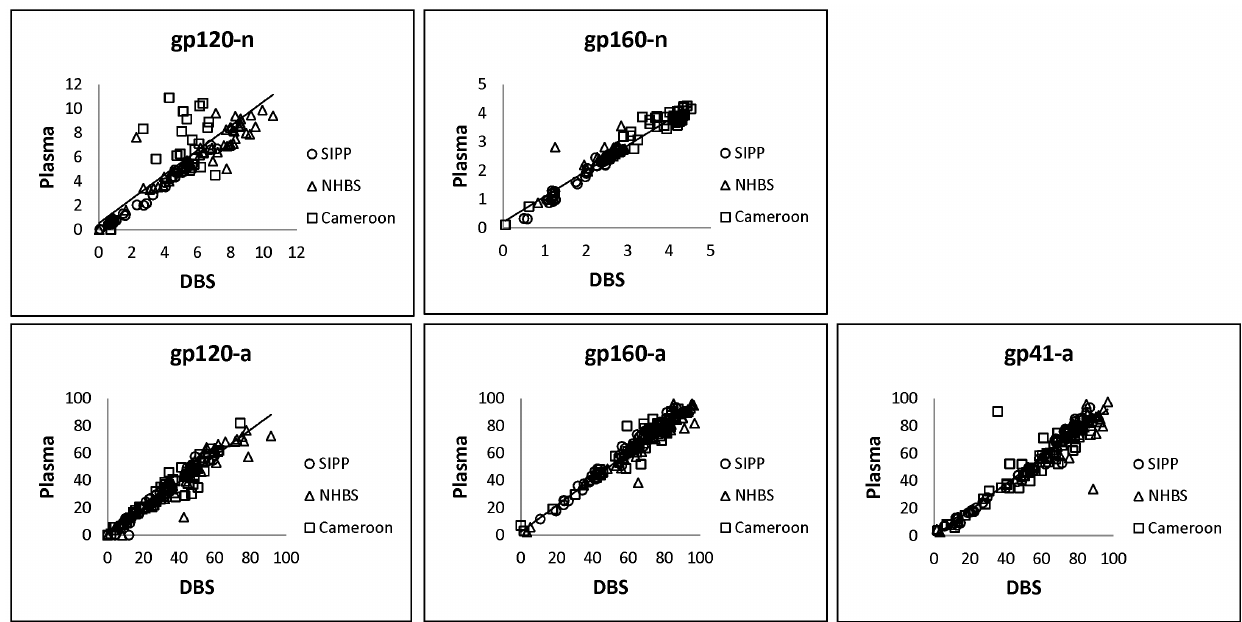
Figure 1. Correlation between plasma and DBS. The normalized MFI values (n) and avidity index (a) for plasma versus DBS were compared for all specimens. The solid line represents the linear trend line for all data points.